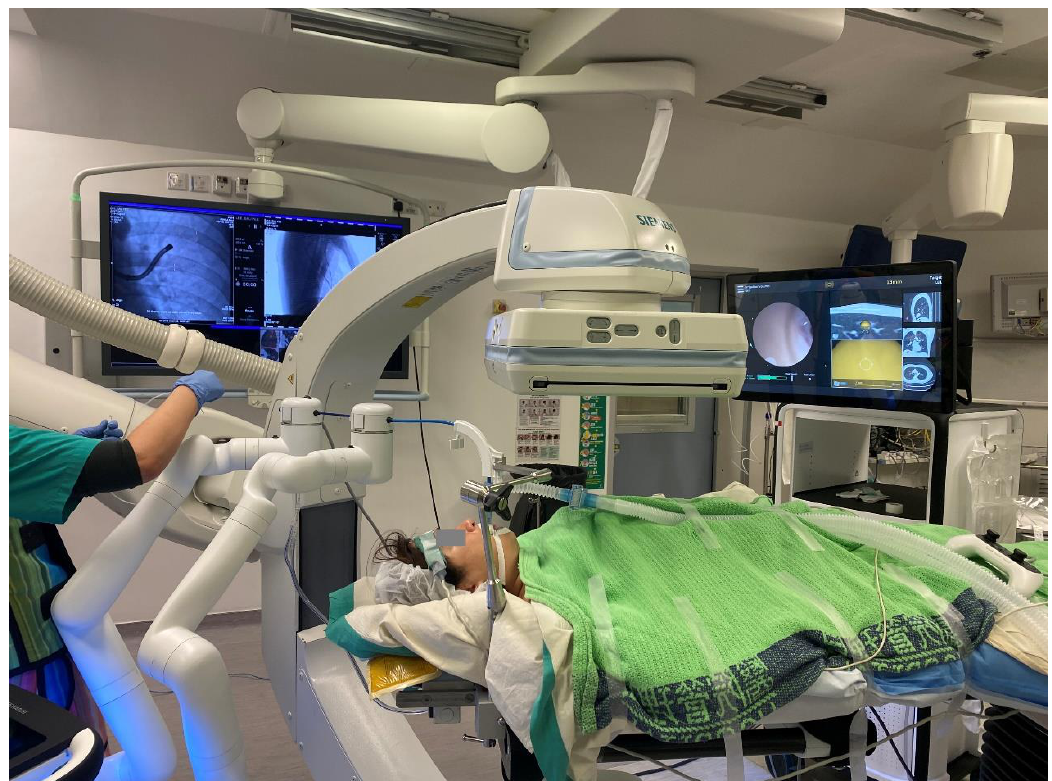
Figure 4. An example of robotic-assisted bronchoscopy by Auris Monarch TM with cone beam CT in a hybrid operating room. This improves the accuracy of navigation, biopsy, or local treatment.